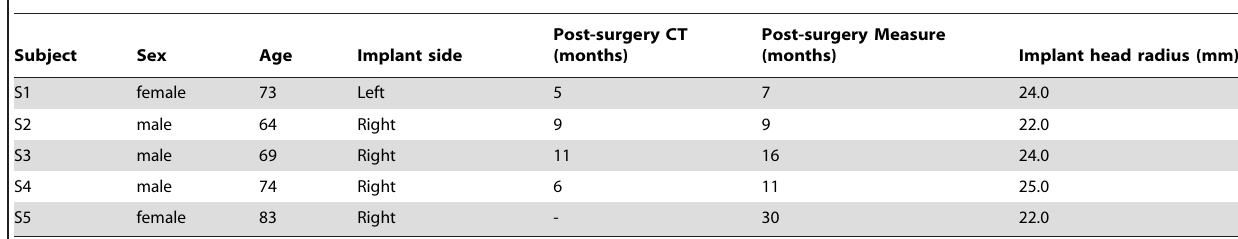
Table 1. Detailed information for the measured